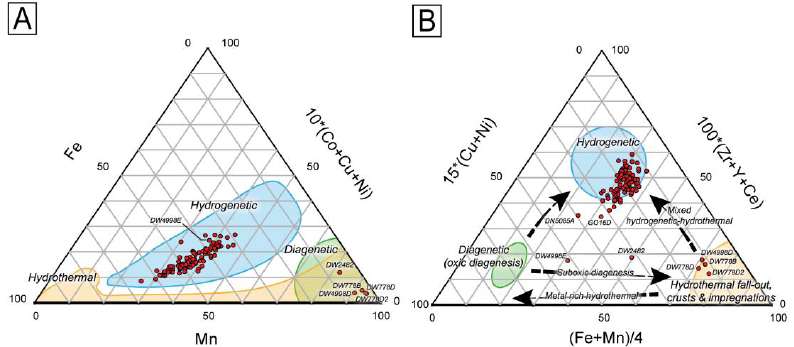
Figure 5. Ternary classification schemes of Fe-Mn samples from New Caledonia’s EEZ ( n = 104) after ( A ) [70] and ( B ) [72].